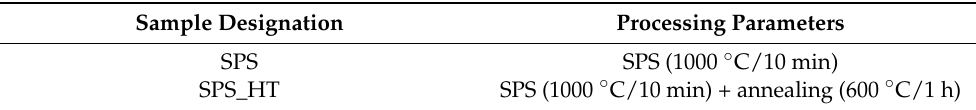
Table 1. Designation of samples and processing parameters.